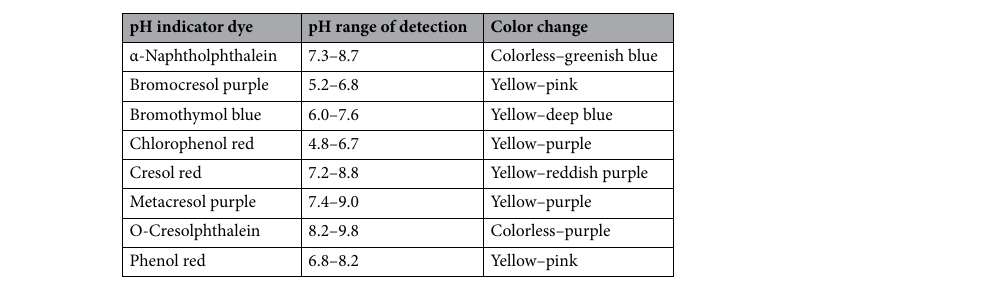
Table 1. pH indicator dyes tested and their ranges of